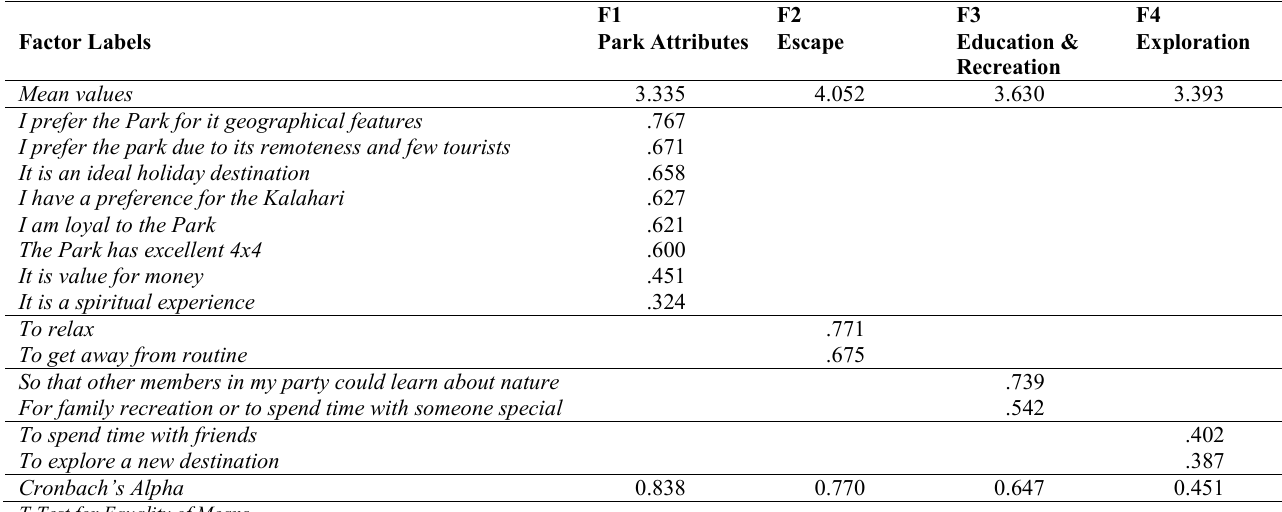
Table 3: Factor analysis (pattern matrix) for the Kgalagadi Transfrontier Park Factor Labels